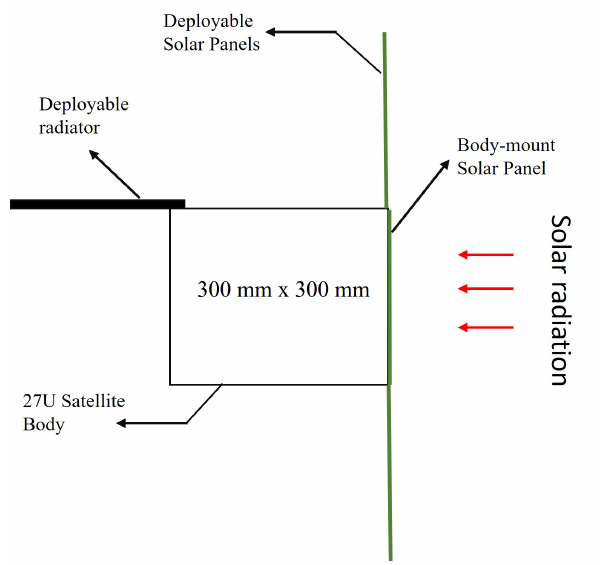
Figure 6. DR-Satellite Orientation with respect to